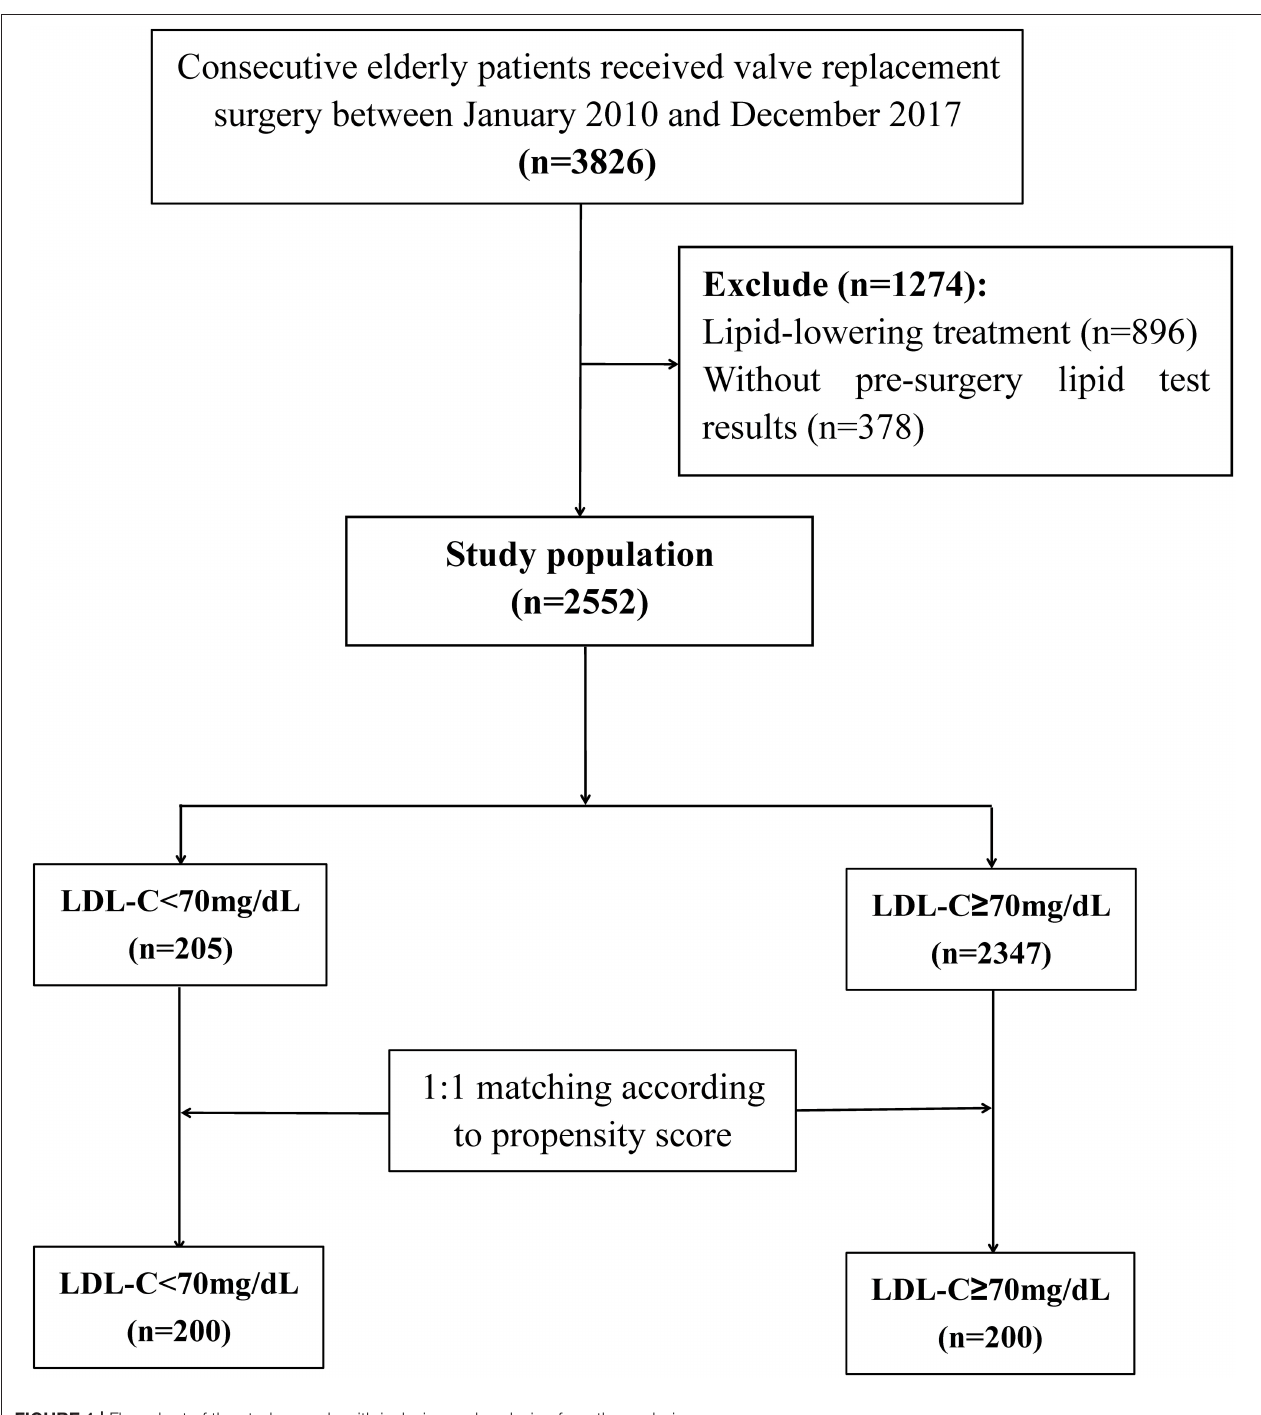
FIGURE 1 | Flow chart of the study sample with inclusion and exclusion from the